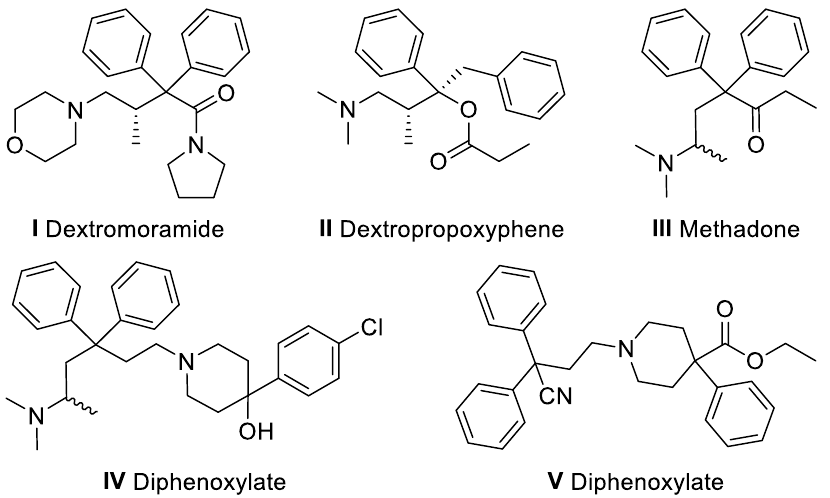
Figure 1. The structural resemblance between dextromoramide ( I ) and other morphine-like analgesics ( II , III ) and antidiarrheals ( IV , V ).